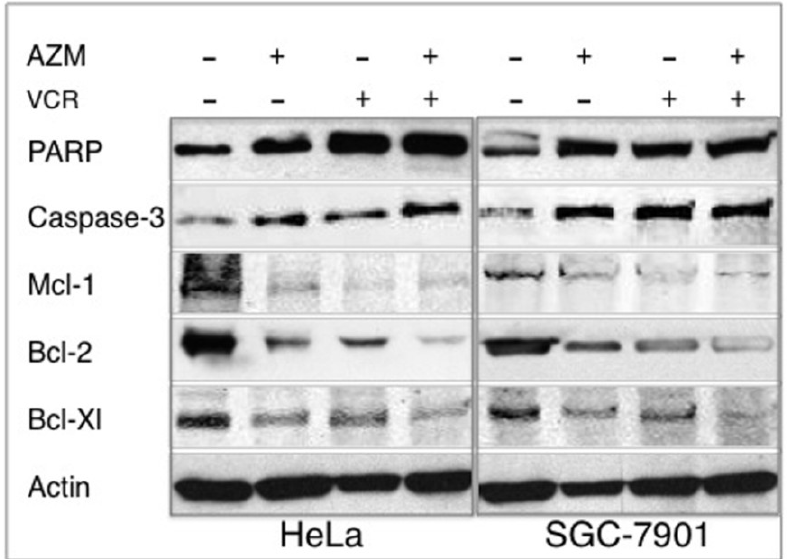
Figure 5. Western blotting analysis of expressions of apoptotic protein. Hela and SGC-7901 cells incubated in a medium containing each 12.5 µg/mL of AZM or VCR alone, or a combination of the two drugs for 48 h, the cell lysates were then used for analyzing the alteration of expressions of apoptotic and anti-poptotic proteins by immunoblotting analysis against indicated antibodies. The experiments were repeated three times and similar results were